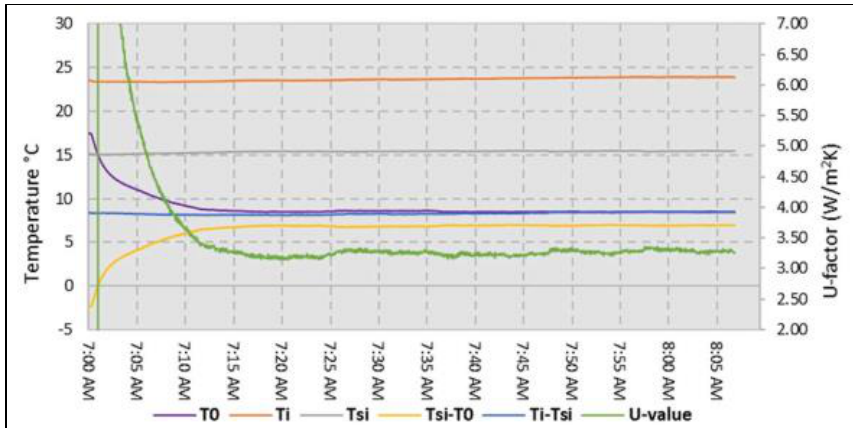
Figure 20. Second Measurement [32].